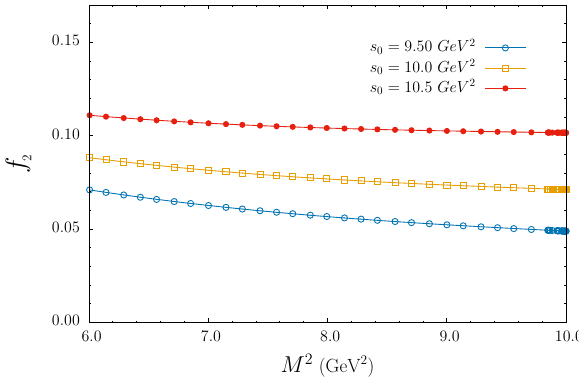
Fig. 1 The dependency of g on M 2 at the fixed values of s 0 for D